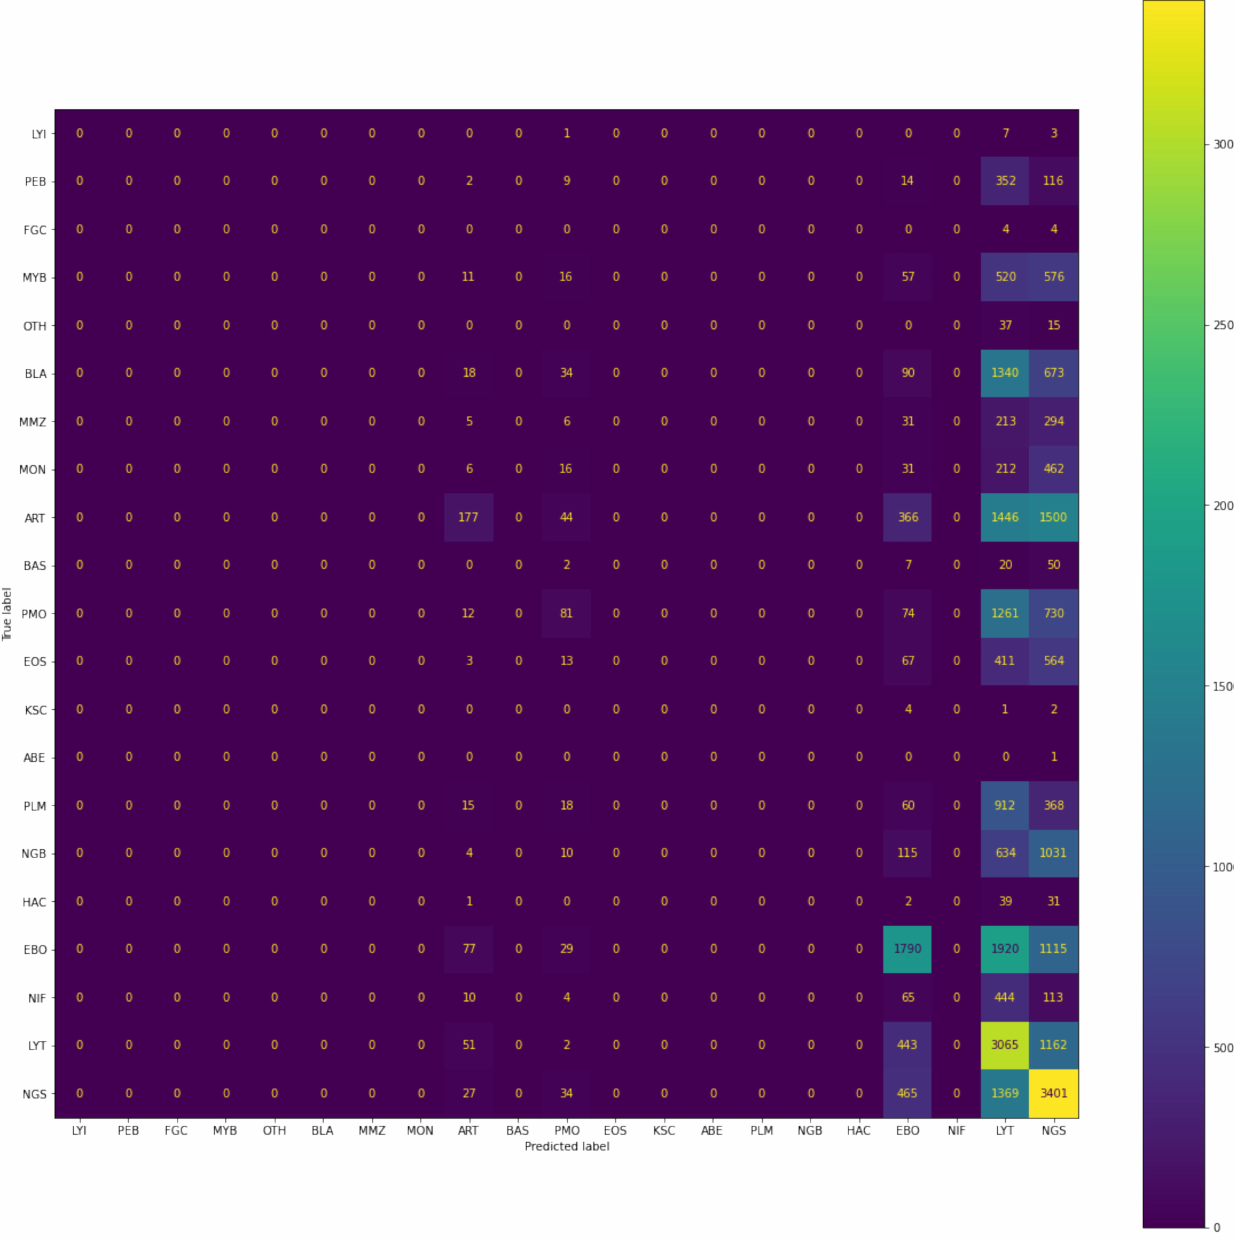
Figure 15. Confusion matrix of predictions made by